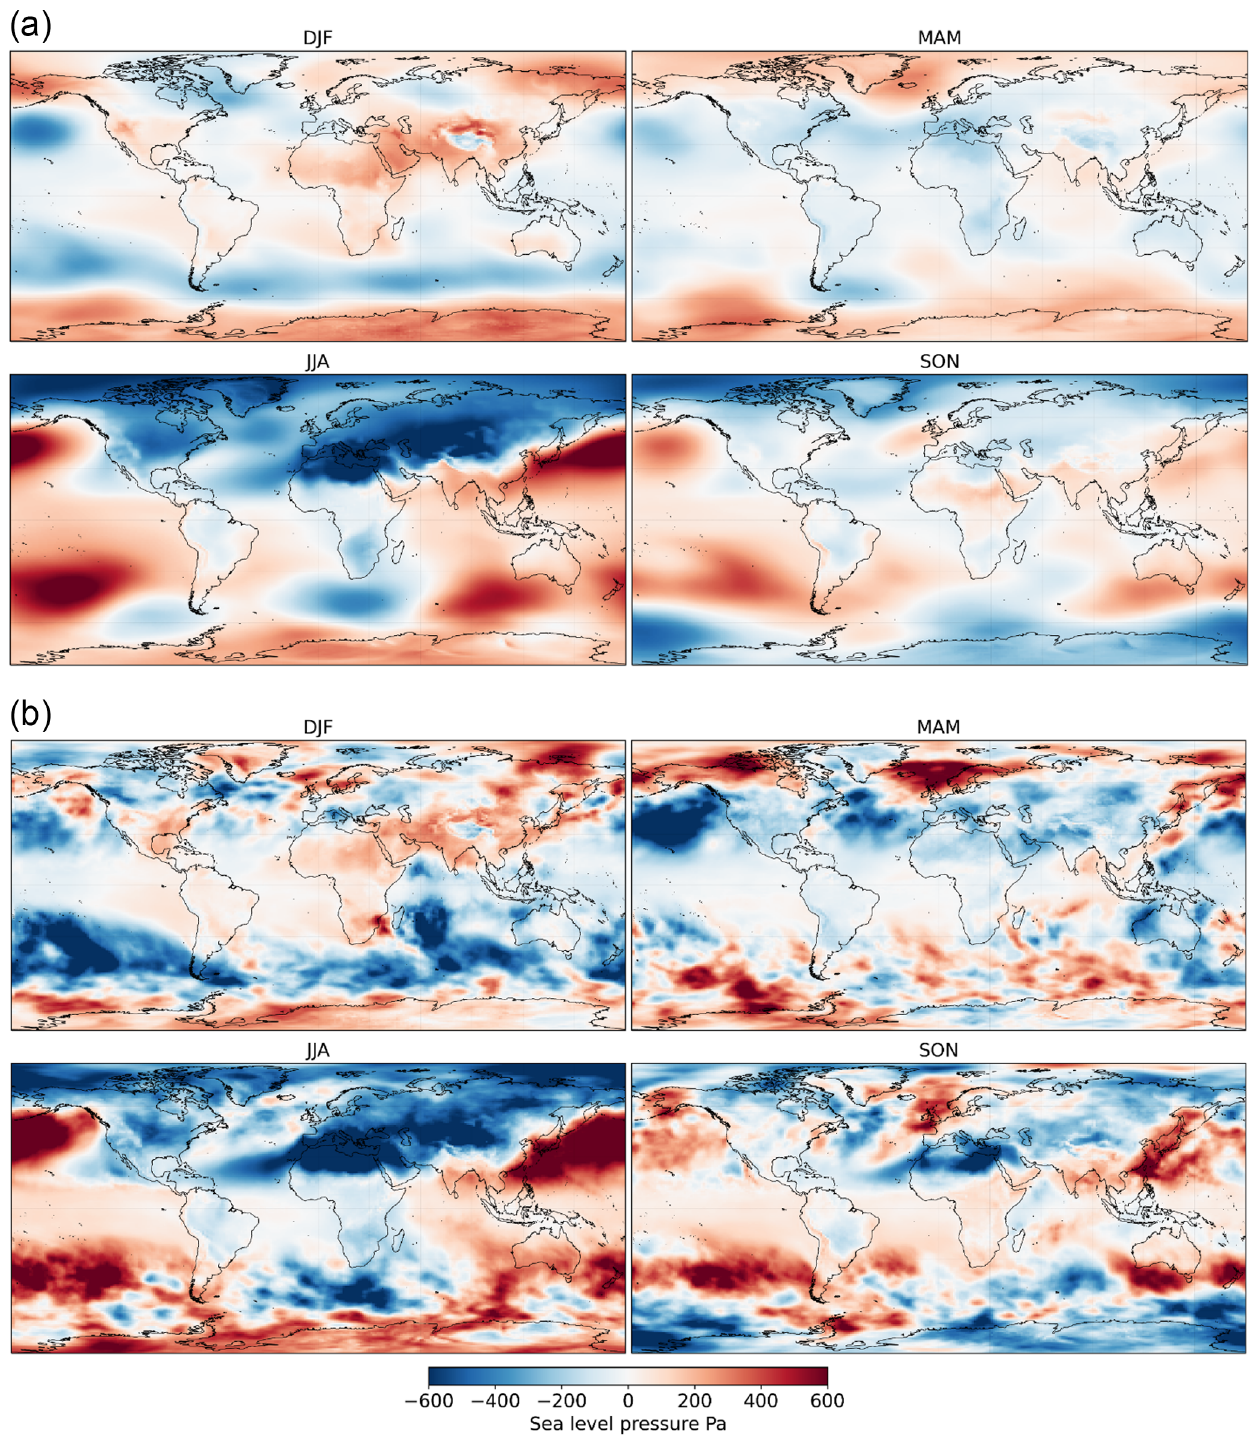
Figure 1. Anomalies (LIG − PI) in sea level pressure. (a) Seasonal mean; (b) seasonal daily minimum. DJF indicates months December– January–February and so